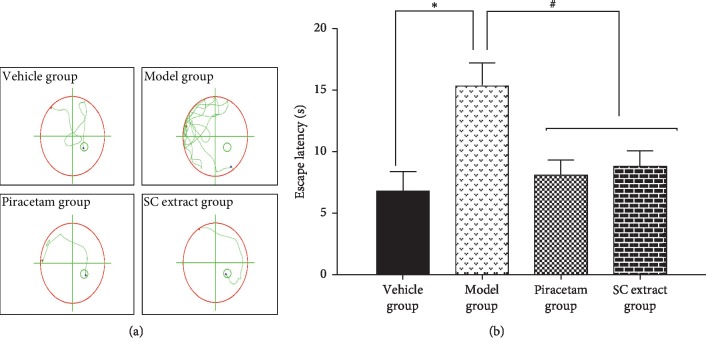
Effects of SC extract on search strategy which was recorded by swimming movement focus (a) and escape latency (b) of the Morris water maze test. Values are means ± SD (n = 10). ∗p < 0.05 compared with control group; #p < 0.05 compared with model group.